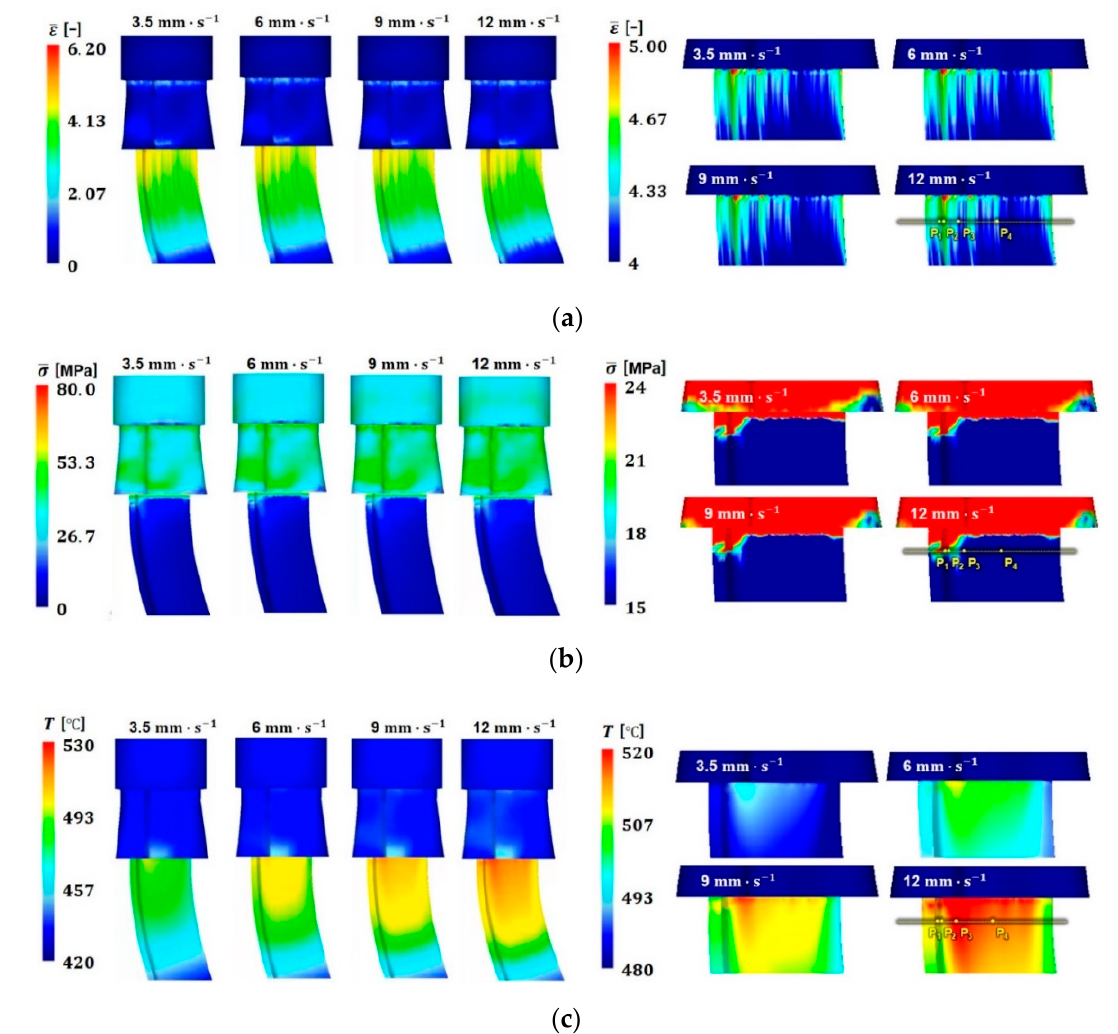
Figure 10. Distribution of the physical quantities with ram speed: ( a ) equivalent plastic strain; ( b ) von Mises effective stress; and ( c ) temperature.